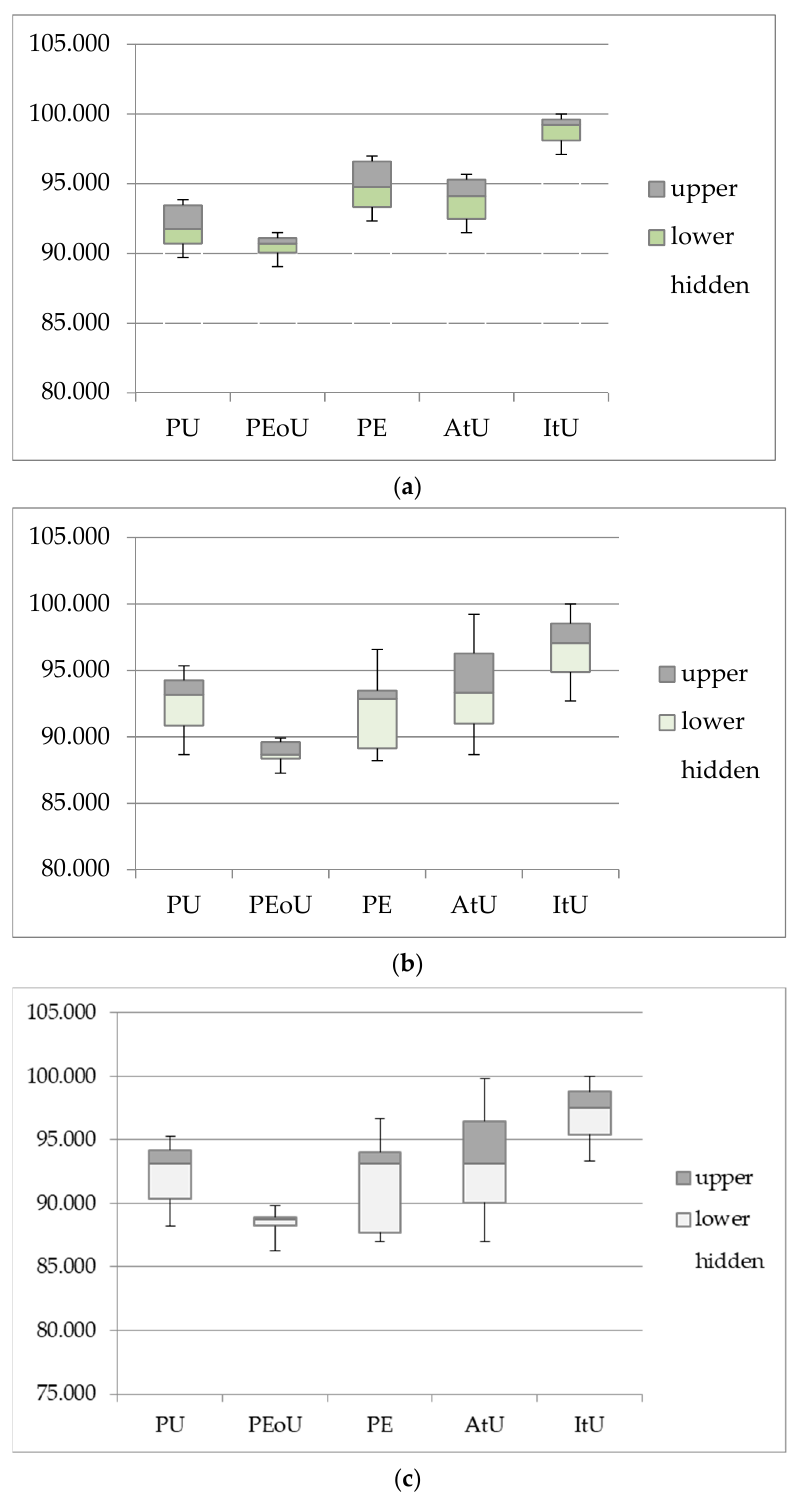
Figure 9. ( a ) Boxplot showing the results for the statements, grouped for the five constructs (Case 1); ( b ) Boxplot showing the results for the statements, grouped for the five constructs (Case 2); ( c ) Boxplot showing the results for the statements, grouped for the five constructs (Case 3). In the following, the model is analyzed only for Case 1, because the other two cases were similar in terms of the answers received from the questionnaires.